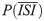
Metrics of structured activity vs lateral inhibition strength.a) Metrics entering in the definition of Q0 versus the synaptic strength g. From top to bottom: Averaged coefficient of variation 〈CV〉N, standard deviation of the cross-correlation matrix σ(C), and the fraction of active neurons n*. The solid (dashed) line refers to the case ΔV = 1 mV (ΔV = 5 mV). The minimum number of active neurons is achieved at g = gmin, this corresponds to a peak amplitude of the PSP APSP = 0.064 mV (APSP = 0.184 mV) for ΔV = 1 mV (ΔV = 5 mV) (for more details see Methods). b) Distributions P(ISI¯) of the average ISI for a fixed ΔV = 5 mV and for two different coupling strengths, g = 4 (red triangle-up symbol) and g = 10 (blue triangle-down). Inset, the distribution P(CV) of the CV of the single neurons for the same two cases. c) Q0 and Qd, as defined in Eqs (1) and (20), versus g for ΔV = 1 mV. d) Same as c) for ΔV = 5 mV. Other parameters as in Fig 1.